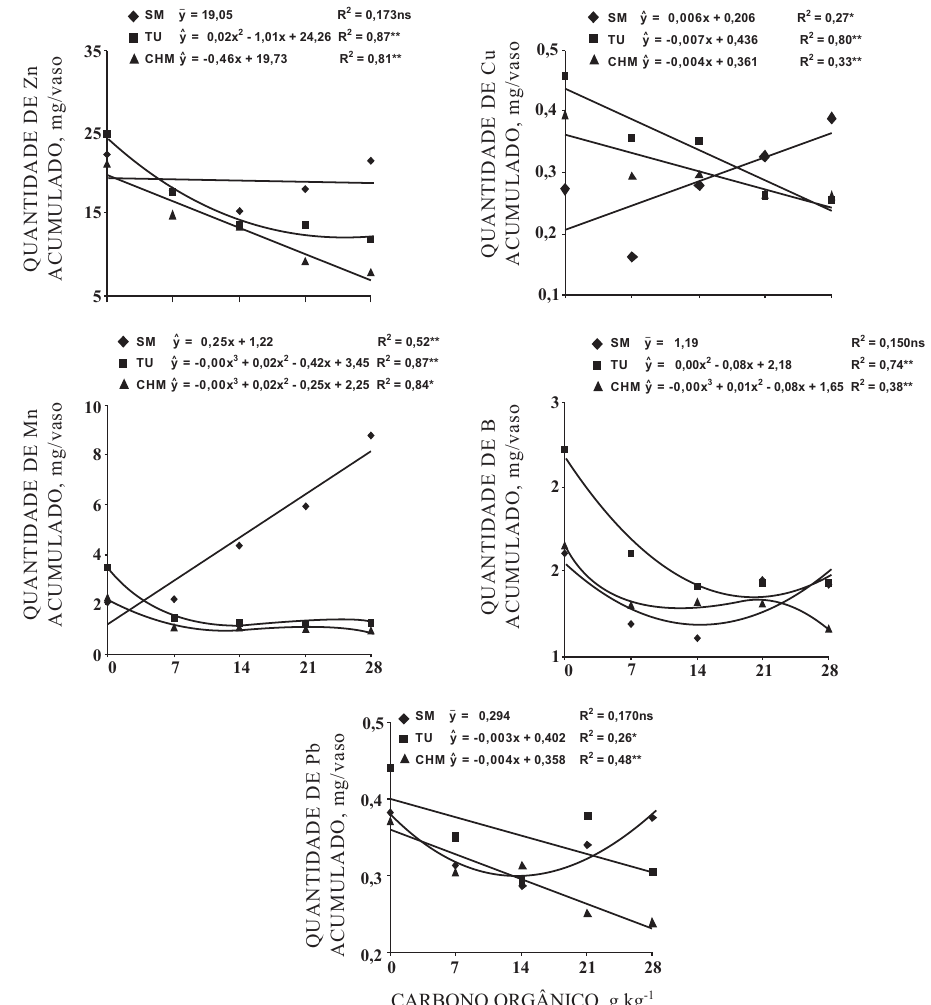
Figura 4. Quantidades acumuladas de zinco, cobre, manganês, chumbo e boro na parte aérea da mostarda em função de doses de carbono orgânico aplicadas ao solo via solomax (SM), turfa (TU) e concentrado húmico mineral (CHM). (ns) não-significativo. (**) e (*) significativos a 1 e 5 %,